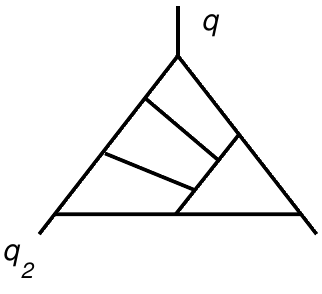
Figure 2 . Massless four-loop vertex diagram with two external (incoming) momenta q and q 2 with q 2 6 = 0 6 = q 2 2 and ( q + q 2 ) 2 = 0. The master integral I 99 corresponds to q 2 2 =